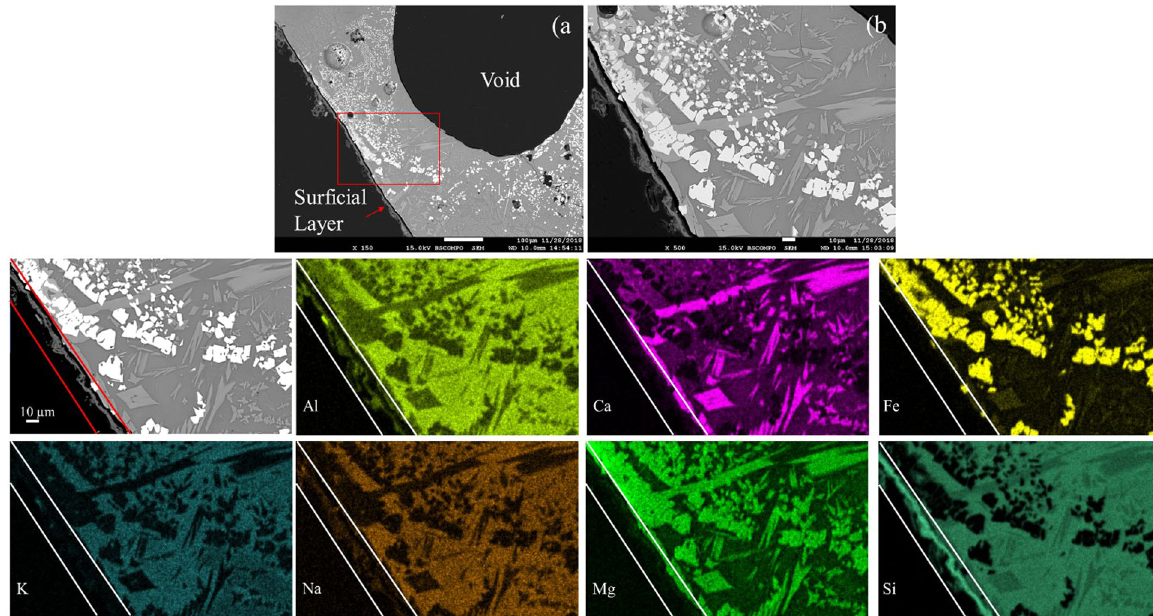
Fig. 2 SEM/EDS images showing heterogeneity and sur fi cial features of BB1b. a BB1b showing a sur fi cial layer on the sample along with a void that has not been exposed to the near- fi eld environment (scale bar is 100 µm). b A magni fi cation of the area in the red box from ( a ) (scale bar is 10 µm). The EDS maps showing the distribution of major elements in a subsection of ( b ) are shown below with lines to guide the location of the sur fi cial layer (scale bar is 10